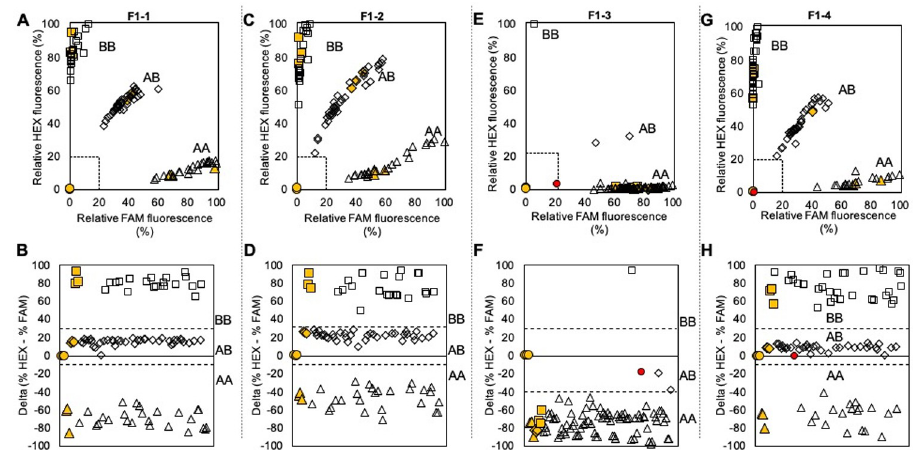
Fig 1. Results from KASP assay for SNPs on Ppe.XapF1 using clean DNA extraction and previously genotyped samples. Solid yellow shapes indicate positive controls, solid red indicates an unknown that failed to amplify, and empty shapes indicate unknowns, with the shape indicating the assigned genotype as follows: circle = no template/no amplification, triangle = AA, diamond = AB, square = BB. Dashed lines in plots in the top row indicate boundaries for no amplification (% fluorescence < ~20% for both fluorophores). Dashed lines in plots in the bottom row indicate delta (% HEX—% FAM) values separating heterozygous and homozygous genotypes, adjusted to reflect assay conditions. A,B = F1-1; C,D = F1-2; E,F = F1-3; G,H = F1-4.